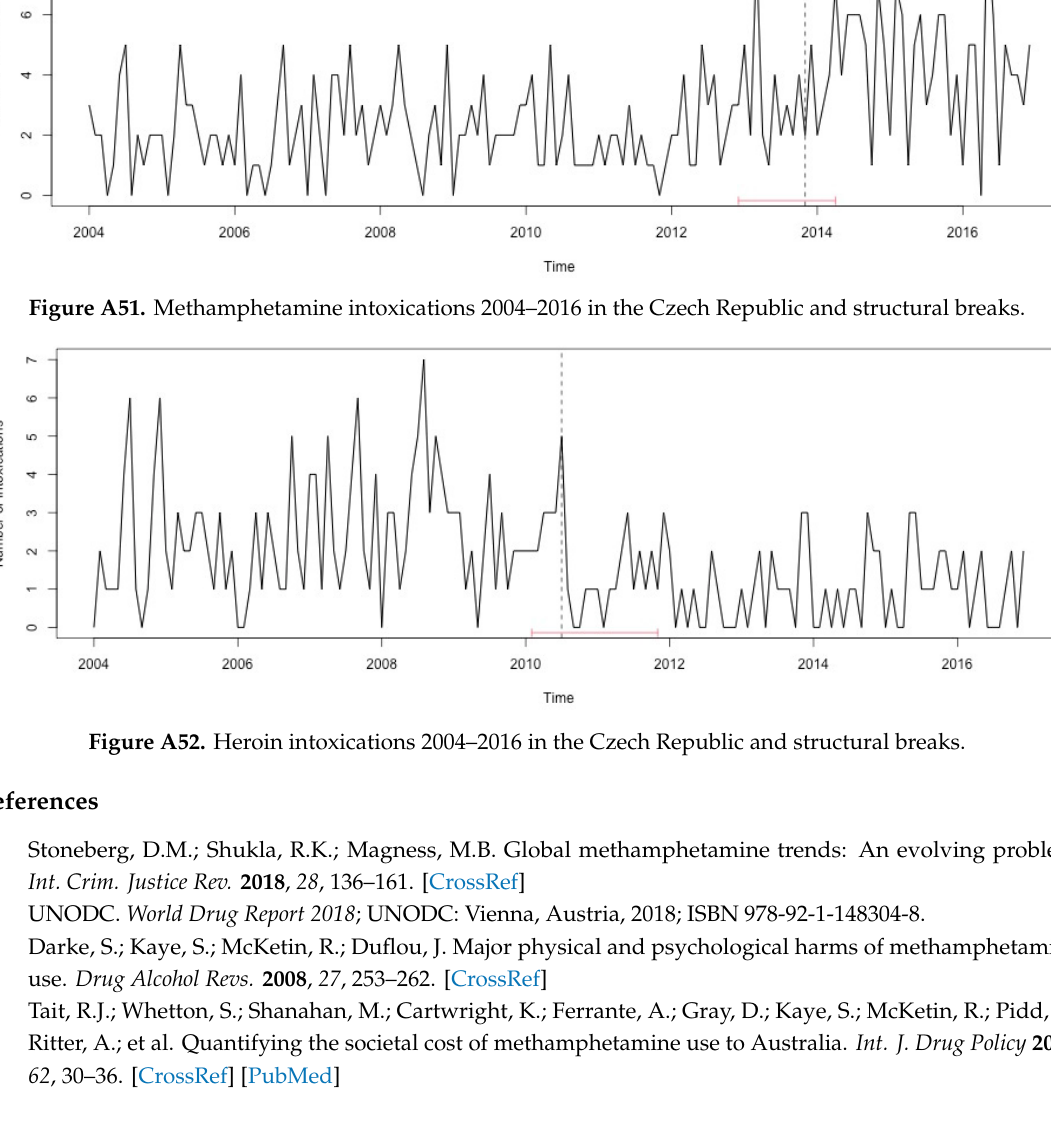
Figure A52. Heroin intoxications 2004–2016 in the Czech Republic and structural breaks.